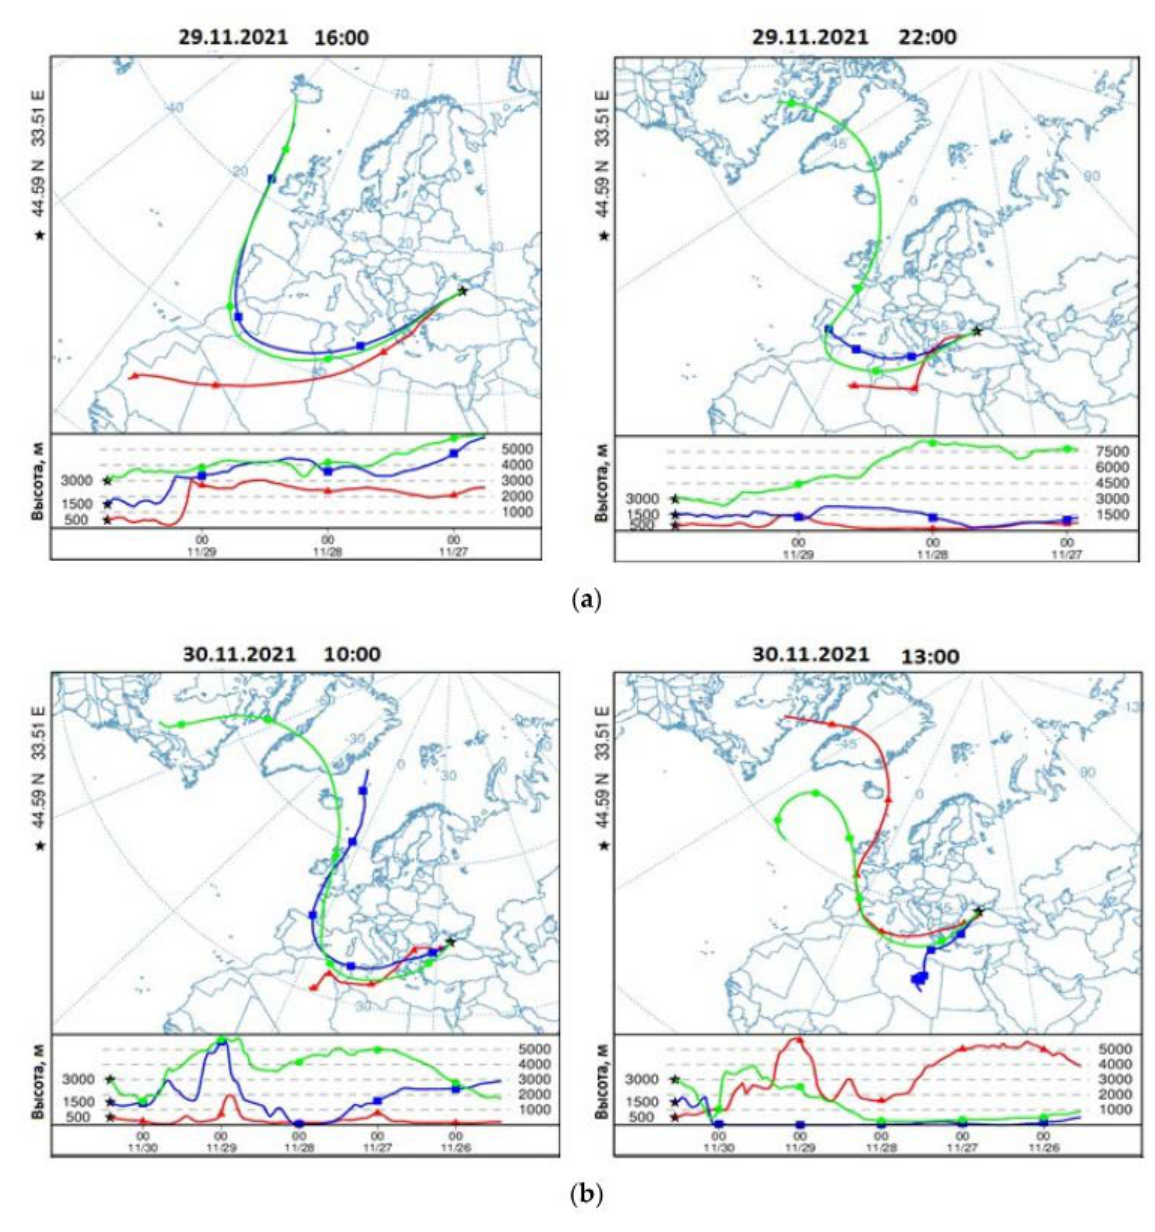
Figure 8. Air masses back-trajectories on 29 ( a ) and 30 ( b ) November 2021 (*—location of station